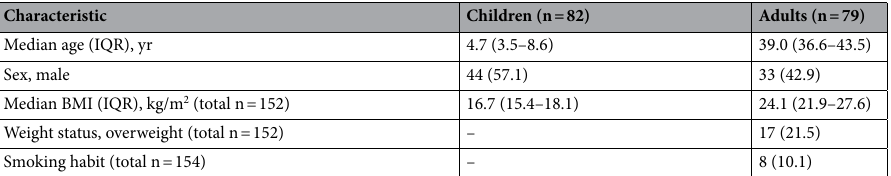
Table 1. Epidemiological characteristics of study population. Values expressed as counts (%) unless otherwise stated. IQR interquartile range, yr years, BMI body mass index.